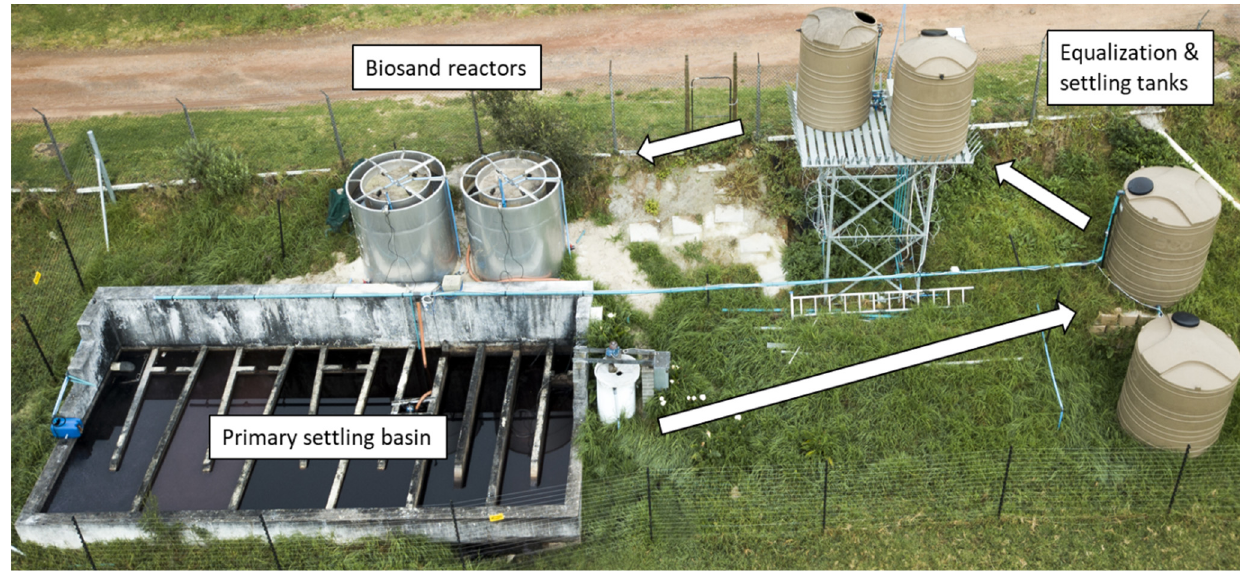
Figure 1. Set up of pilot biosand reactor system treating winery wastewater.